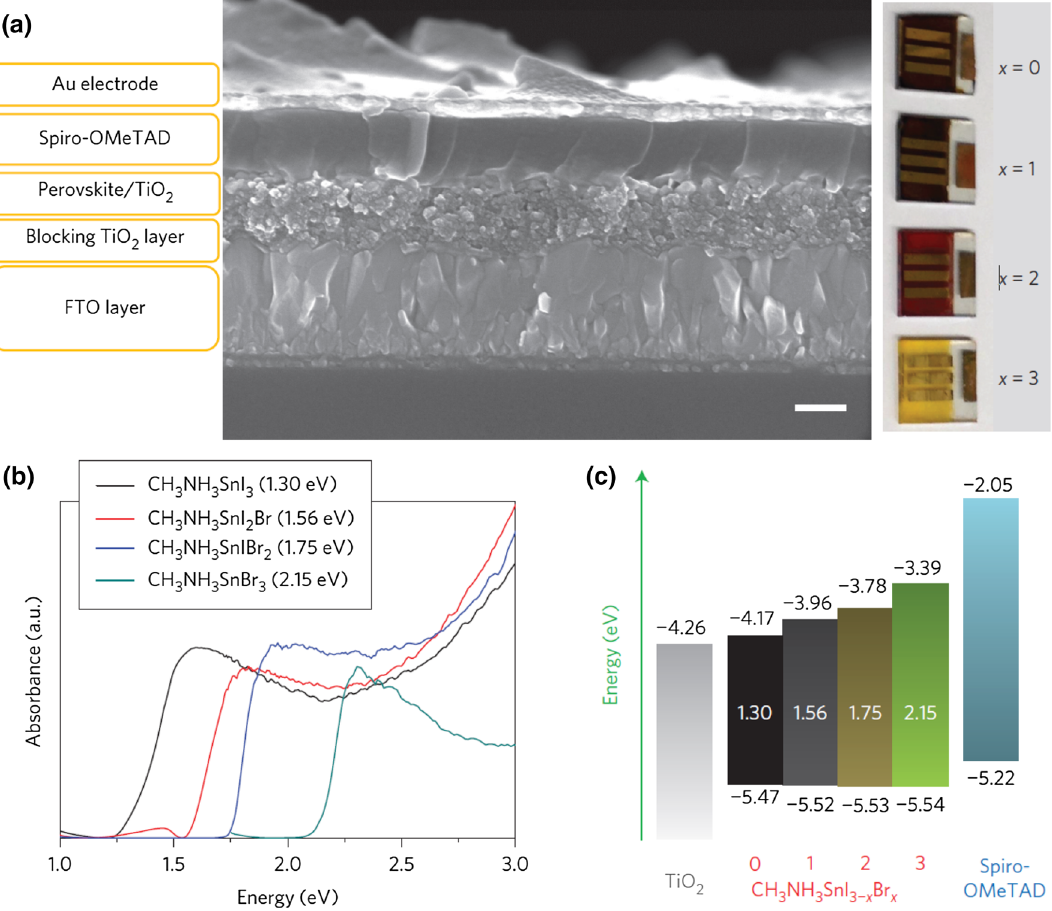
Fig. 4 a Perovskite solar cell device architecture with different absorber layer colour on the right panel. b Absorption spectra of the CH 3 NH 3 SnI 3-x Br x ( x = 0, 1, 2, 3) perovskites. c Schematic energy-level diagram of CH 3 NH 3 SnI 3-x Br x with TiO 2 and spiro-OMeTAD